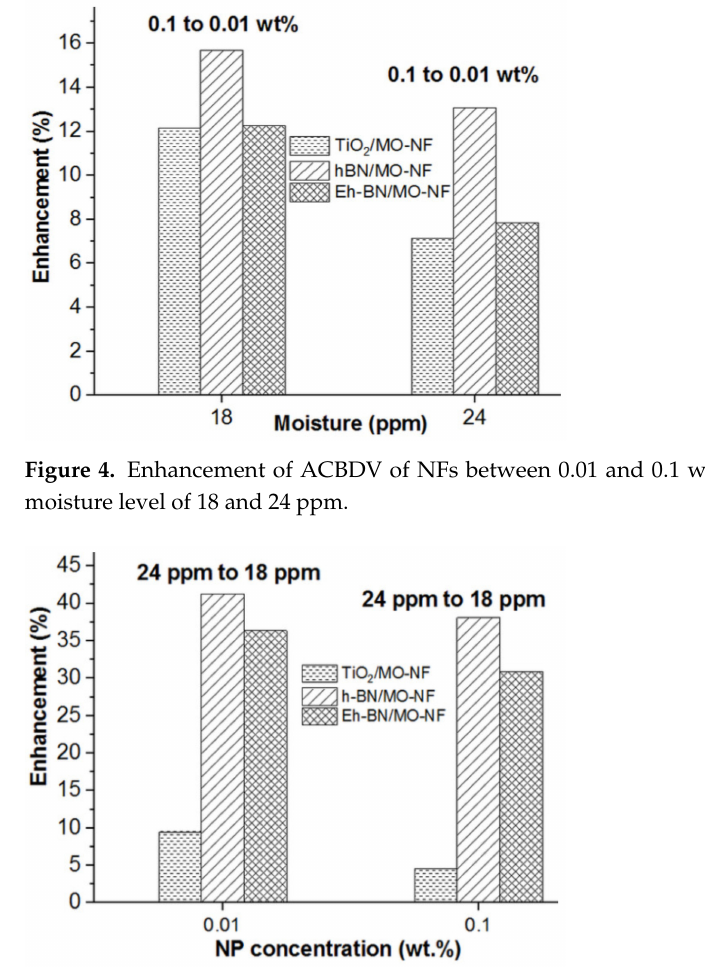
Figure 5. Enhancement of ACBDV of NFs between 18 and 24 ppm moisture level for 0.01 and 0.1 wt % of NP concentration.